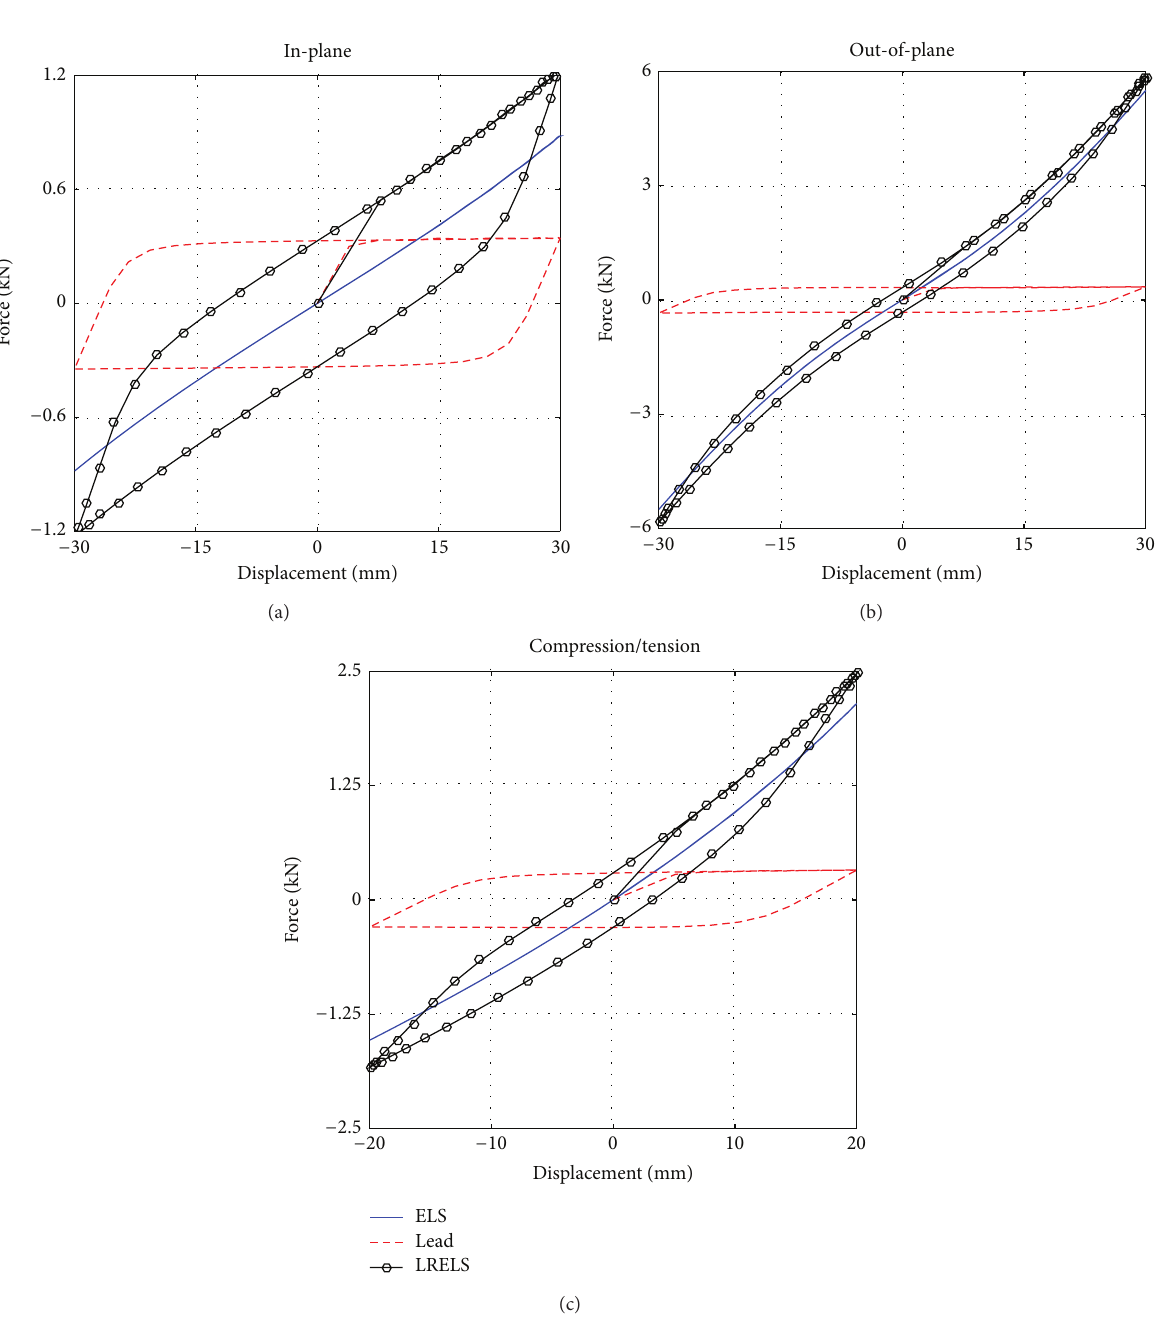
𝑛 = 2 were used. The other parameters of the hysteresis model were identified using the least squares method and are